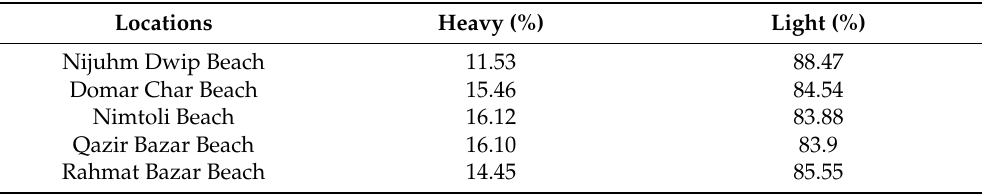
Table 2. The visual detection of the heavy minerals fractions using the transmitted and reflected light